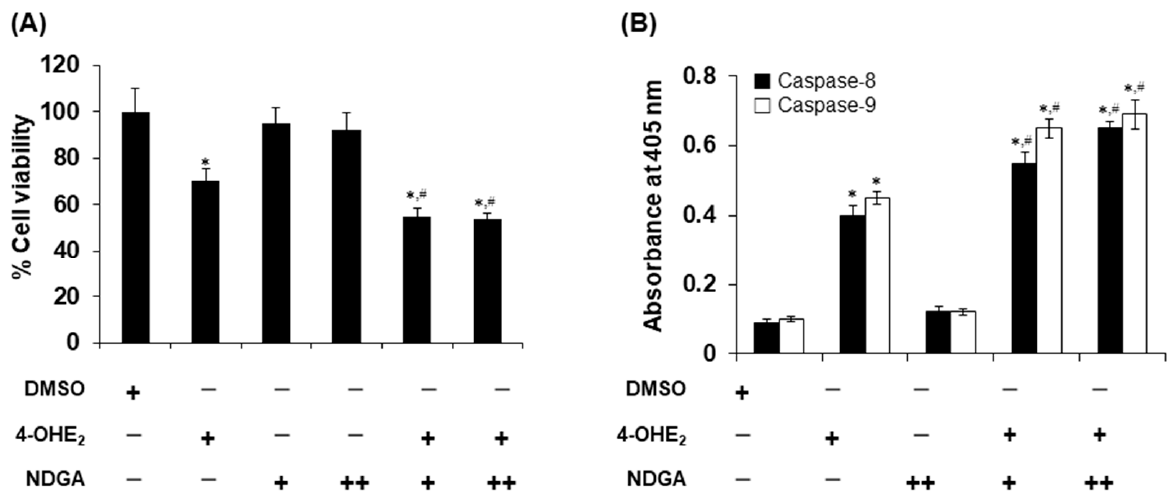
Figure 4. Effects of nordihydroguaiaretic acid on 4-hydroxyestradiol-induced cell death and apoptosis. MCF-7 cells were treated with 4-OHE 2 (50 µ M) and NDGA (either 25 or 50 µ M). Cell viability was measured using the MTT assay ( A ) and apoptosis was determined by the detection of increased caspase-8 and -9 levels using human caspase ELISA kits ( B ). The label “+” represents results obtained from samples treated with 25 µ M of NDGA, whereas “++” means samples treated with 50 µ M NDGA. Data are shown as mean values of three measurements ± SE. Each experiment was independently repeated at least three times. * indicates p < 0.001 between compound-treated and DMSO-treated cells. # indicates significantly differences between samples treated with 4-OHE 2 and 4-OHE 2 + NDGA ( p < 0.05).